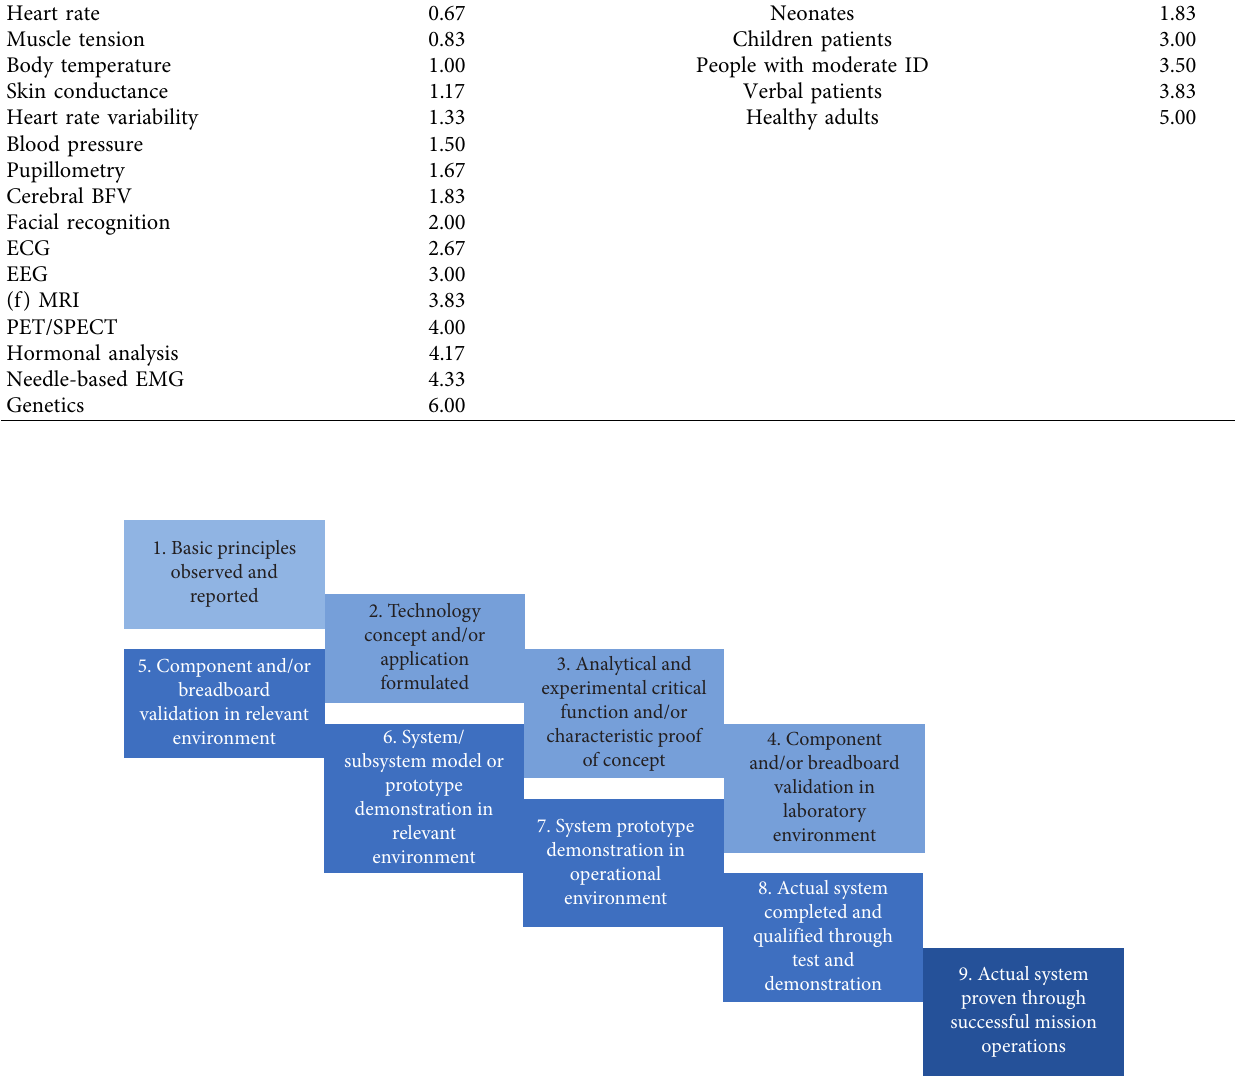
Figure 2: Technology readiness level descriptions used by the United States Department of Defense [6]. The figure is adapted from a figure used by the European Association for Research and Technology Organizations [9] to improve legibility.